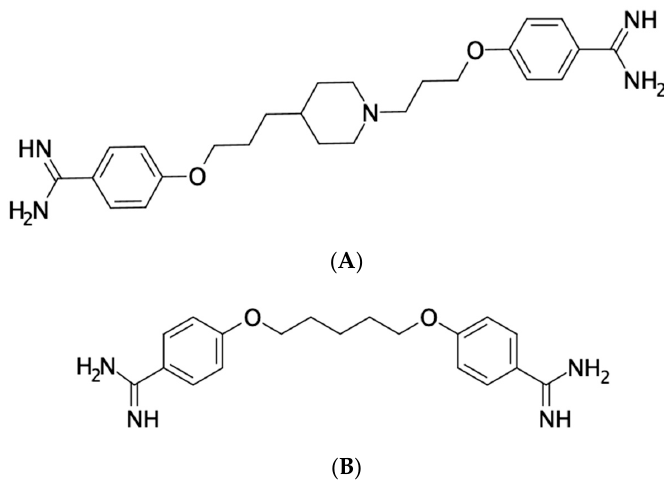
Figure 1. Chemical structures of the aromatic diamidines ( A ) T-2307 and ( B ) pentamidine. In order to assess the mechanism of action of T-2307 against yeast, Shibata et al. con- ducted a series of experiments [13]. To investigate the effects of T-2307 on the mitochon- drial function in S. cerevisiae and C. albicans , the accumulation of the fluorescent dye Mi- toTracker Red CMXRos (MTR), a mitochondrial marker that concentrates in active mito- chondria by membrane potential, was evaluated by microscopy. The presence of T-2307 at a concentration of 1 µM resulted in a less intense staining of mitochondria by MTR, indicating that the mitochondrial function had collapsed. These results were similar to those observed with carbonyl cyanide m -chlorophyenylhydrazone (CCCP), a protono- phore and uncoupler of oxidative phosphorylation. In both S. cerevisiae and C. albicans, the number of whole cells with intense staining of the mitochondria decreased in the presence of T-2307 in a concentration-dependent fashion. In addition, a gradual and dose-depend- ent collapse of the mitochondrial membrane potential was also noted in mitochondria iso- lated from S. cerevisiae that were exposed to T-2307 or pentamidine. However, the T-2307 concentration required to cause a collapse in the membrane potential of at least 50% (30 µM) was markedly higher than the concentration required to inhibit the growth of the isolate (MIC 0.002 µM, or 0.001 µg/mL). With pentamidine, a reduction in the mitochon- drial membrane potential of at least 50% occurred at a concentration of 5 µM, while the MIC against S. cerevisiae was reported to be 1.5 µM, or 0.5 µg/mL. The disconnect between the T-2307 concentration required to cause the collapse of the mitochondrial membrane potential and that needed to inhibit the growth of the organism (MIC) was postulated to be due to the intracellular accumulation of T-2307, as others have reported that this agent concentrates approximately 5000-fold within C. albicans cells from an extracellular me- dium via transporter mediated systems [16]. Subsequent work has indicated that T-2307 transport into C. albicans occurs through a high-affinity spermine and spermidine transport system that is regulated by Agp2, a plasma membrane protein involved in the update of L-carnitine and polyamines and other substrates in S. cerevisiae [17]. It is known that the uptake of polyamines, organic compounds having more than two amino groups, is dependent upon the mitochondrial membrane potential [18]. Interestingly, the activity of T-2307 against a S. cerevisiae strain with a Δ agp2 mutation was markedly reduced when compared to the wild-type strain (MIC >8 µg/mL vs. 0.00012 µg/mL, respectively). The implications of this finding for the potential development of resistance to T-2307 are un- known.